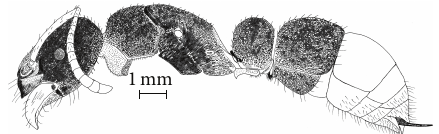
Figure 1: Side view of the holotype worker of B. umgodikulula .